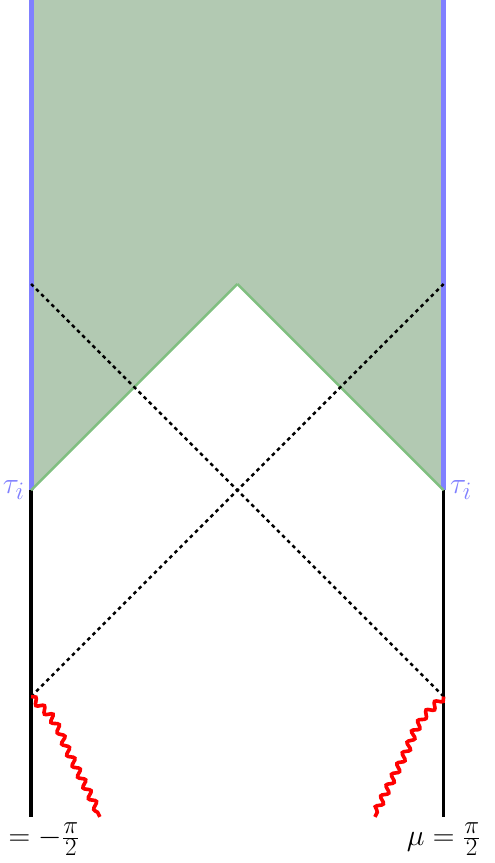
Figure 4 . We draw the Penrose diagram for the geometry describing the transition from black hole to eternal traversable wormhole in ( (cid:28); (cid:22) ) space. The double trace deformation will be